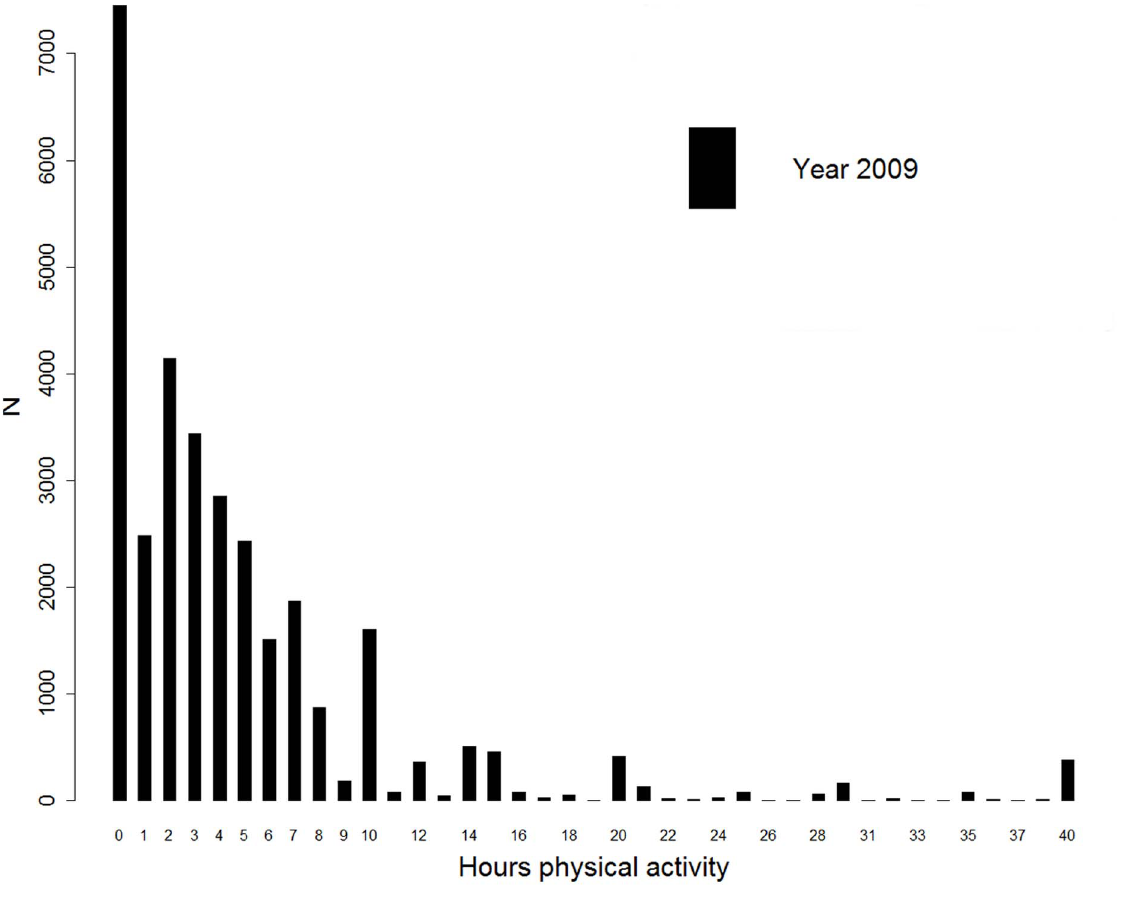
Figure 1. Frequency distribution of PA. doi:10.1371/journal.pone.0062525.g001 Table 1. Descriptive statistics of the study sample for 2006 ( N =25,309) and 2009 ( N =31,783) respectively.